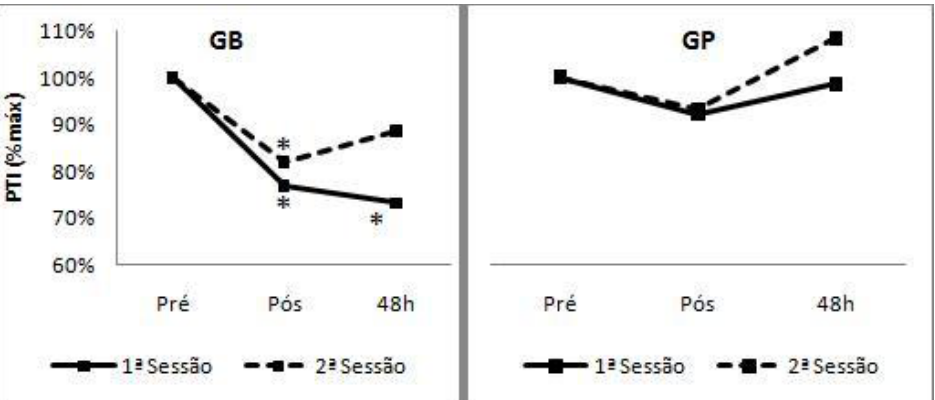
Figura 4. Mudanças no PTI antes, imediatamente depois e 48 horas após as 2 sessões de EEM para os grupos GB e GP. Os asteriscos (*) indicam diferença significativa (p<0,05) em relação à condição basal da respectiva